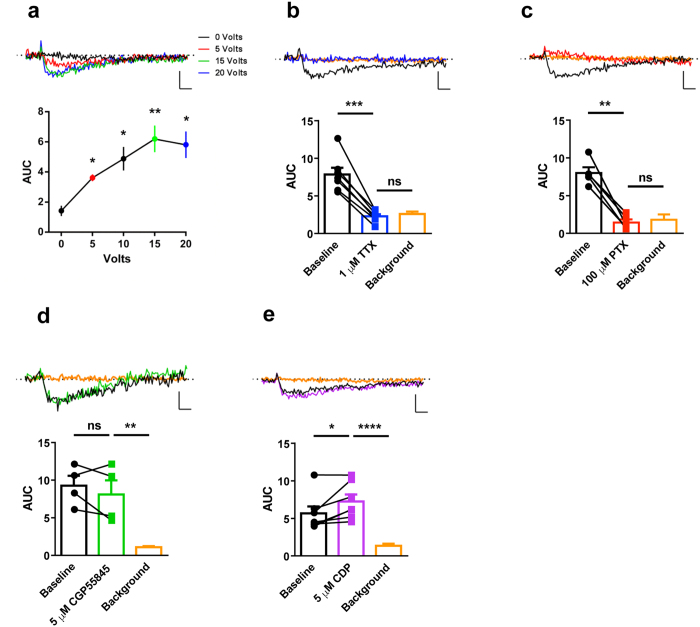
Characterization of the VSDI-recorded fIPSPs.(a) Increasing stimulation intensity every 5 minutes time steps significantly enhances the signal compared to 0 Volts [lower panel, one-way ANOVA with repeated measures over stimulation intensities (F(2,605,13,02) = 12,95, p = 0.0005) followed by Tukey post-hoc test. n = 6 slices from 5 mice]. (b) 1 μM Tetrodotoxin (TTX) significantly abolishes the signal, which is statistically not different from the background, lower panel, n = 7 slices from 5 mice. (c) 100 μM Picrotoxin (PTX) significantly abolishes the signal, which is then not different from background, lower panel, n = 5 slices from 3 mice. (d) 5 μM CGP55845 does not affect the hyperpolarization signal, lower panel, n = 4 slices from 2 mice. (e) 5 μM Chlordiazepoxide (CDP) significantly increases the signal, lower panel, n = 7 slices from 4 mice. In all graphs, signal of interest has been assessed in a ROI covering the whole CA1. In all figures, traces in upper panels are the average of traces from each experimental condition. Bars (b–e) and points (a) represent mean ± s.e.m. whereas over imposed lines (b–e) are single values. Statistical significance has been assessed with two-tailed paired t-test between baseline condition and drug application, while two-tailed unpaired t-test has been used between drug application and respective background (b–e). Scale bars are 25 milliseconds on X-axis and 0.05% ΔF*F−1 on Y-axis. *p <0.05, **p < 0.01, ***p < 0.001, ****p < 0.0001, ns = not significant.